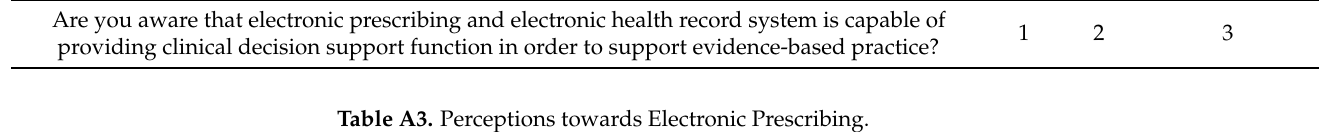
Table A3. Perceptions towards Electronic Prescribing.